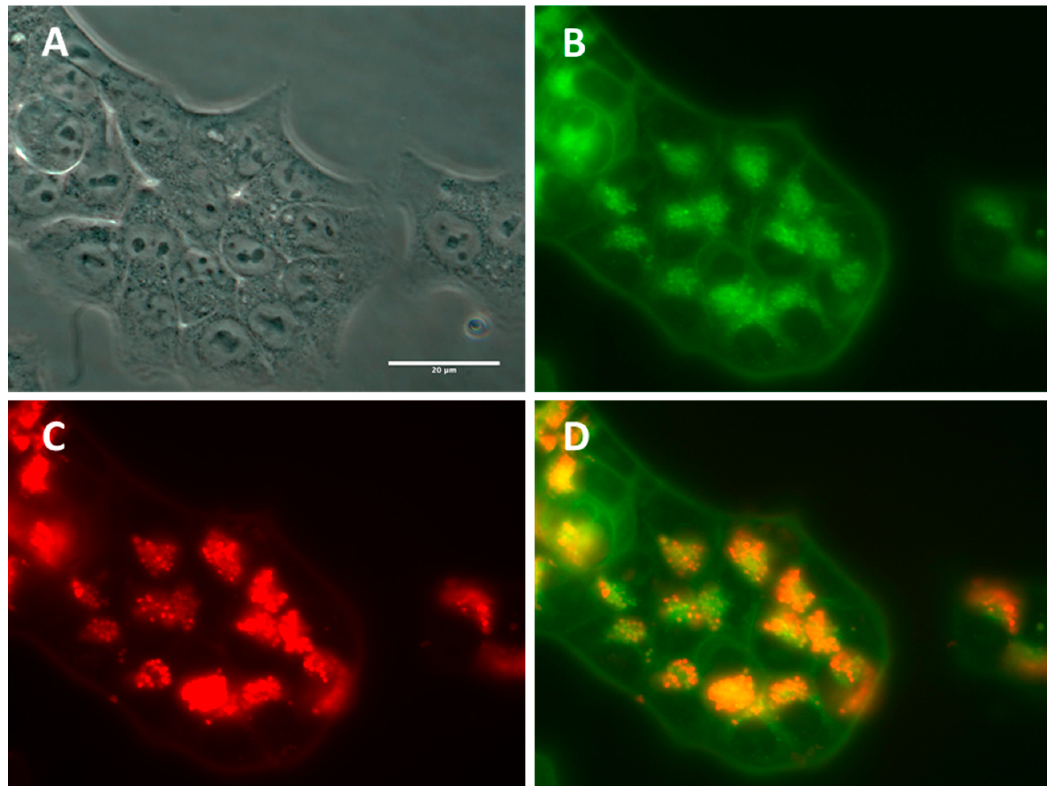
Figure 4. Lysosomal localization of LumiLys 650 NPs in HCT-116 cells. HCT-116 cells were incubated with the LumiLys 650 NPs (100 μ g/mL) for 48 h, and lysosomes were labeled with a commercial Lysotracker ® lysosome tracking kit. ( A ) Phase contrast and ( B ) green fluorescence images of Lysotracker were obtained at 63× magnification. ( C ) LumiLys 650 NPs appear in red. ( D ) Merge channels showed co-localization of both signals in yellow. Scale bar corresponds to 20 μ m.